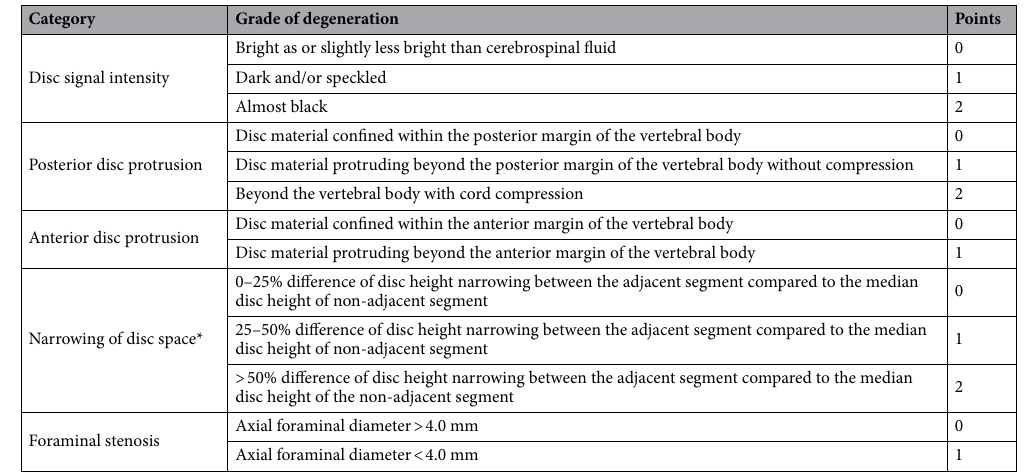
Table 1. Five category grading system for segmental degeneration. *The disc height was calculated as the mean value of the anterior, the middle and the posterior DH of each segment (see Fig. 1).